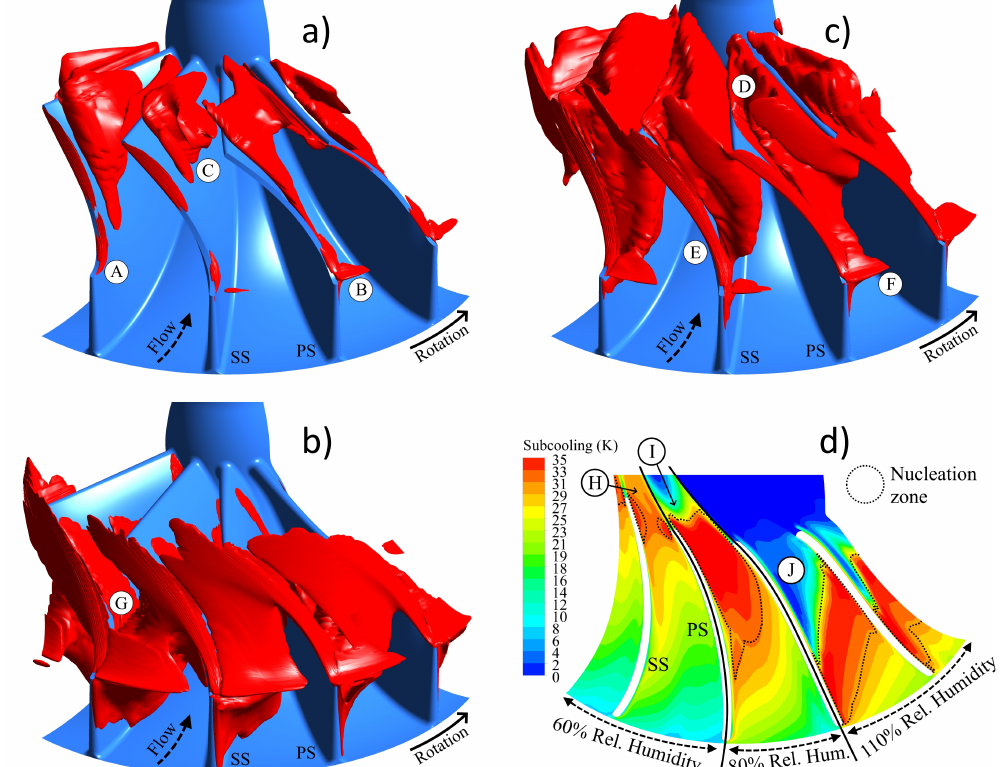
Figure 5. Isosurfaces bounding nucleation zones and contour plot of subcooling. ( a ) Nucleation: 60% relative humidity. ( b ) Nucleation: 80% relative humidity. ( c ) Nucleation: 110% relative humidity. ( d ) Subcooling at 50% normalized